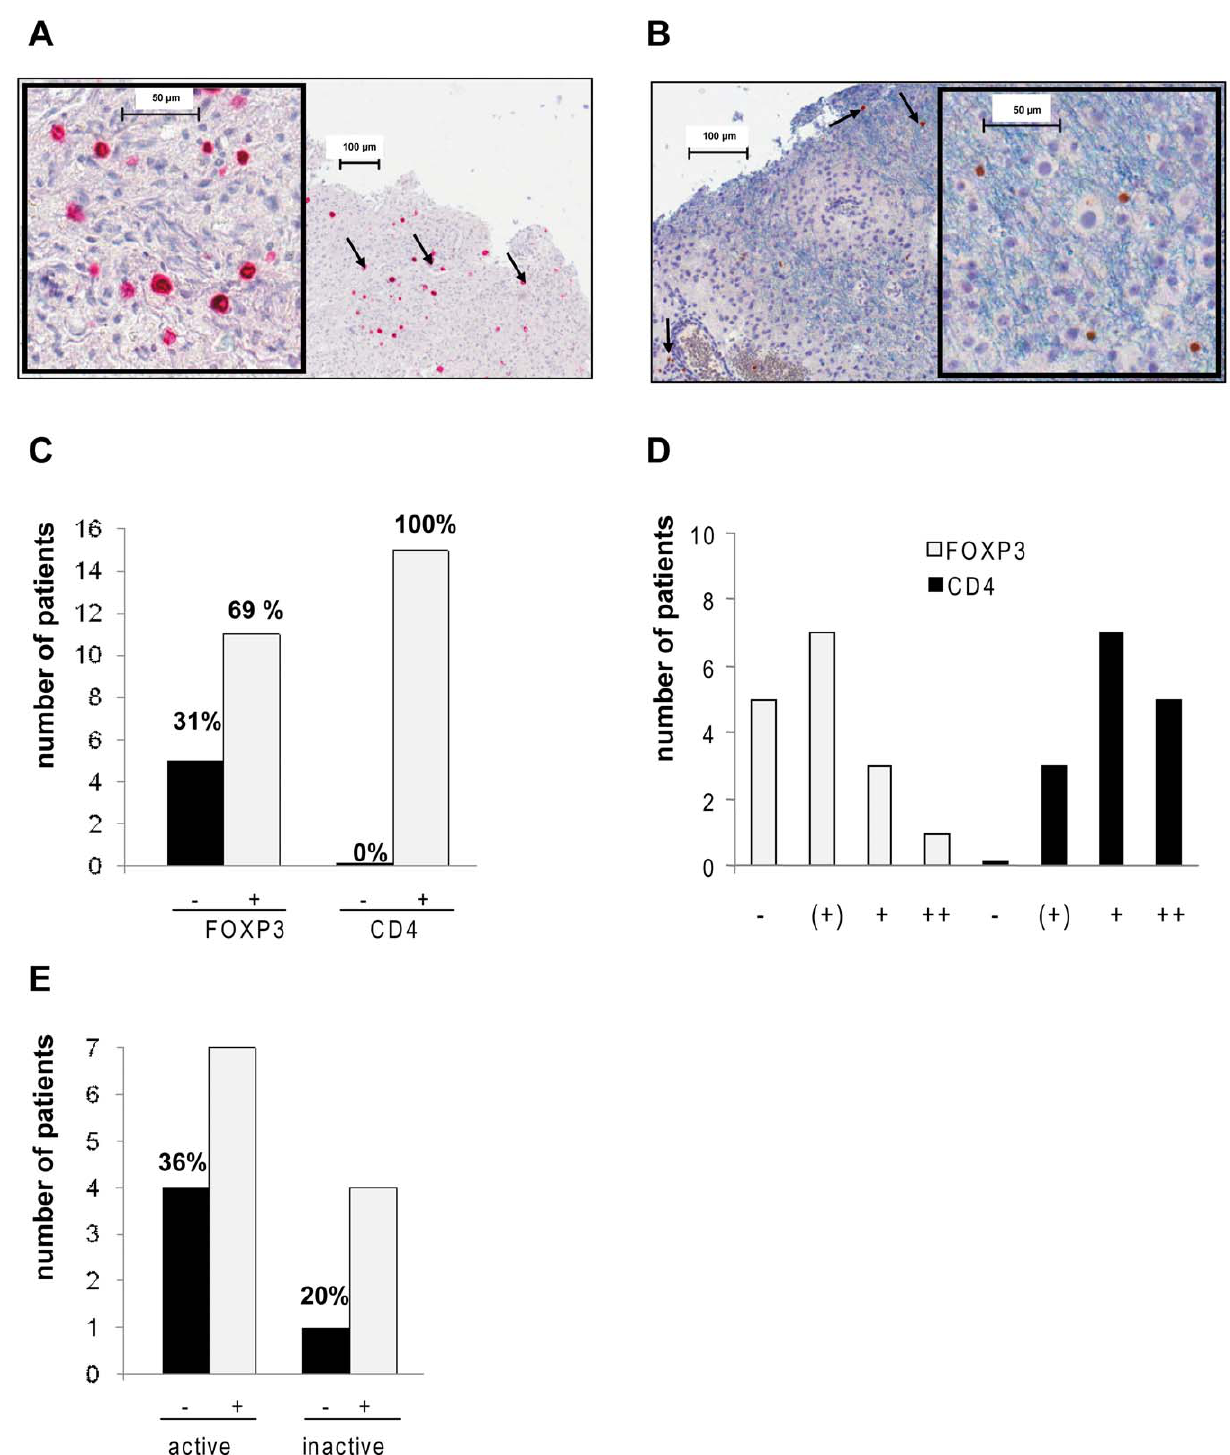
Figure 1. Prevalence of CD4 + and FOXP3 + cells in MS lesions. Brain biopsies of 16 MS patients were analyzed by immunohistochemistry for the presence of CD4 + and FOXP3 + cells. Sections of each biopsy were stained with CD4 mAb, FOXP3 mAb or isotype control mAbs. Whole-slide analysis by complete scanning of the section and computer-aided analysis of positive cells was performed. ( A ) Representative CD4 immunohistochemistry of MS lesion. Positive cells show red cell surface staining. Bar indicates m m scale in two different magnifications. Tissue was hematoxylin counterstained prior to analysis. ( B ) Representative FOXP3 immunohistochemistry of MS lesion. Positive cells show brown nuclear staining. Bar indicates m m scale in two different magnifications. Tissue was hematoxylin counterstained prior to analysis. ( C ) Number of patients with CD4 + T cells in the section (0% negative, 100% positive) and number of patients with FOXP3 + cells in the analyzed section (31% negative with 69% positive for FOXP3). ( D ) Number of patients grouped by their content of FOXP3 + cells and CD4 + cells respectively in the analyzed section: ‘‘-‘‘ indicates